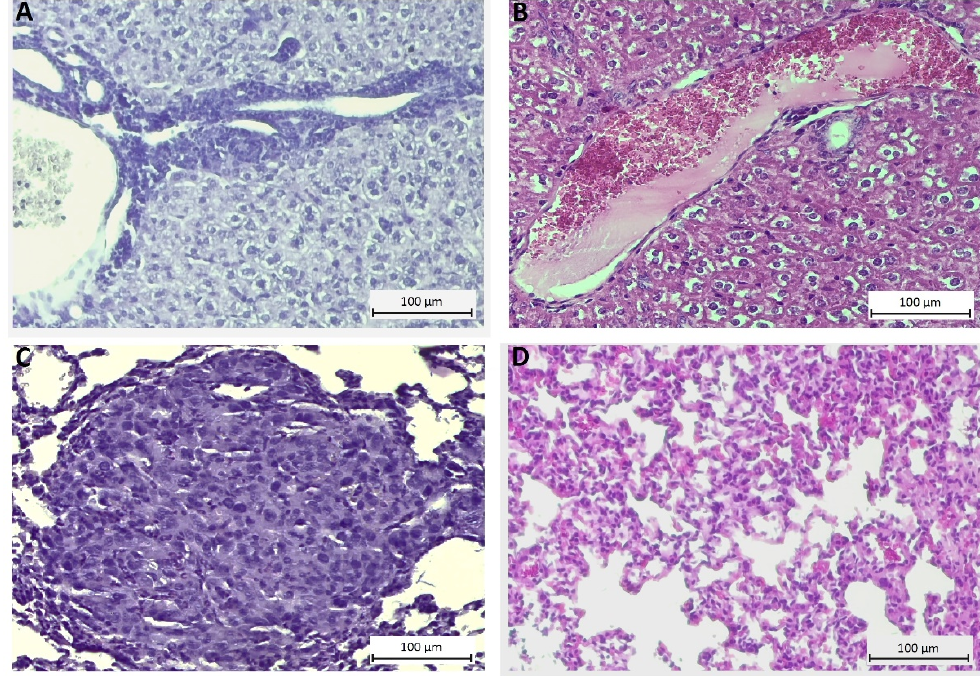
Figure 7. Representative images of liver and lung sections stained with hematoxylin–eosin (HE) to evaluate the cytotoxic impact of the MTX and GLU–MTX on the mice tissues. ( A ) Liver